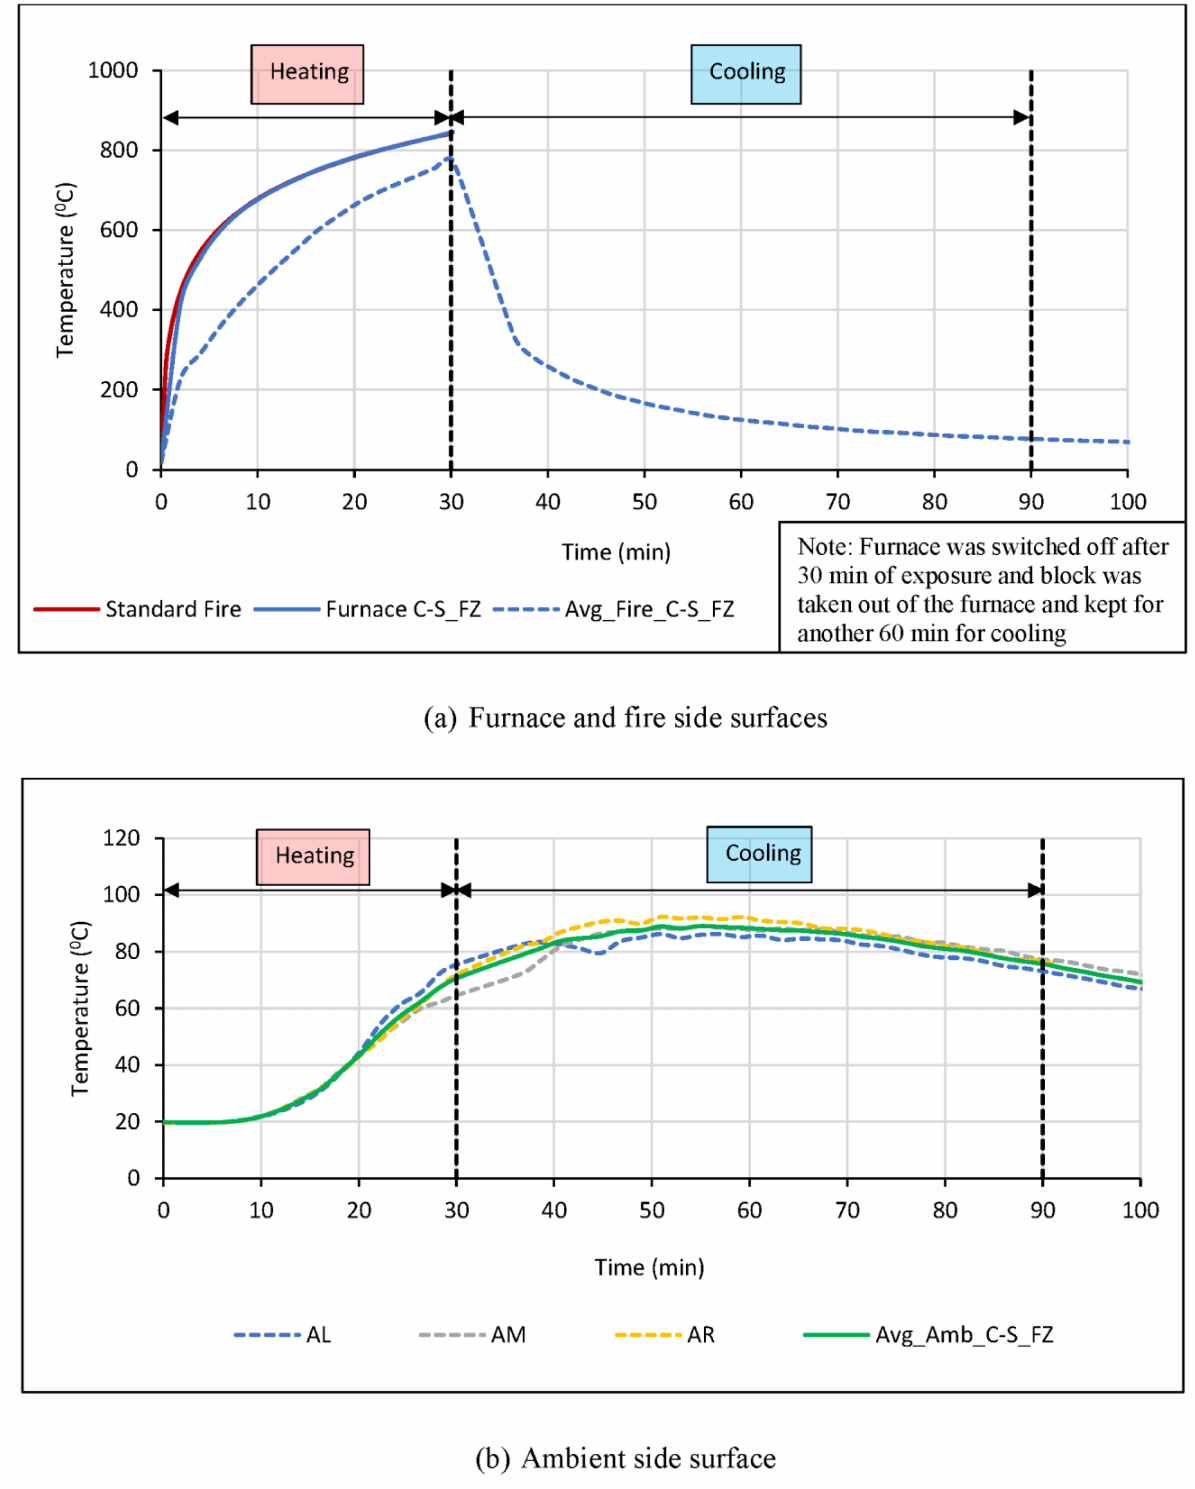
Figure 16. Time–temperature curves of C-S block from the bushfire